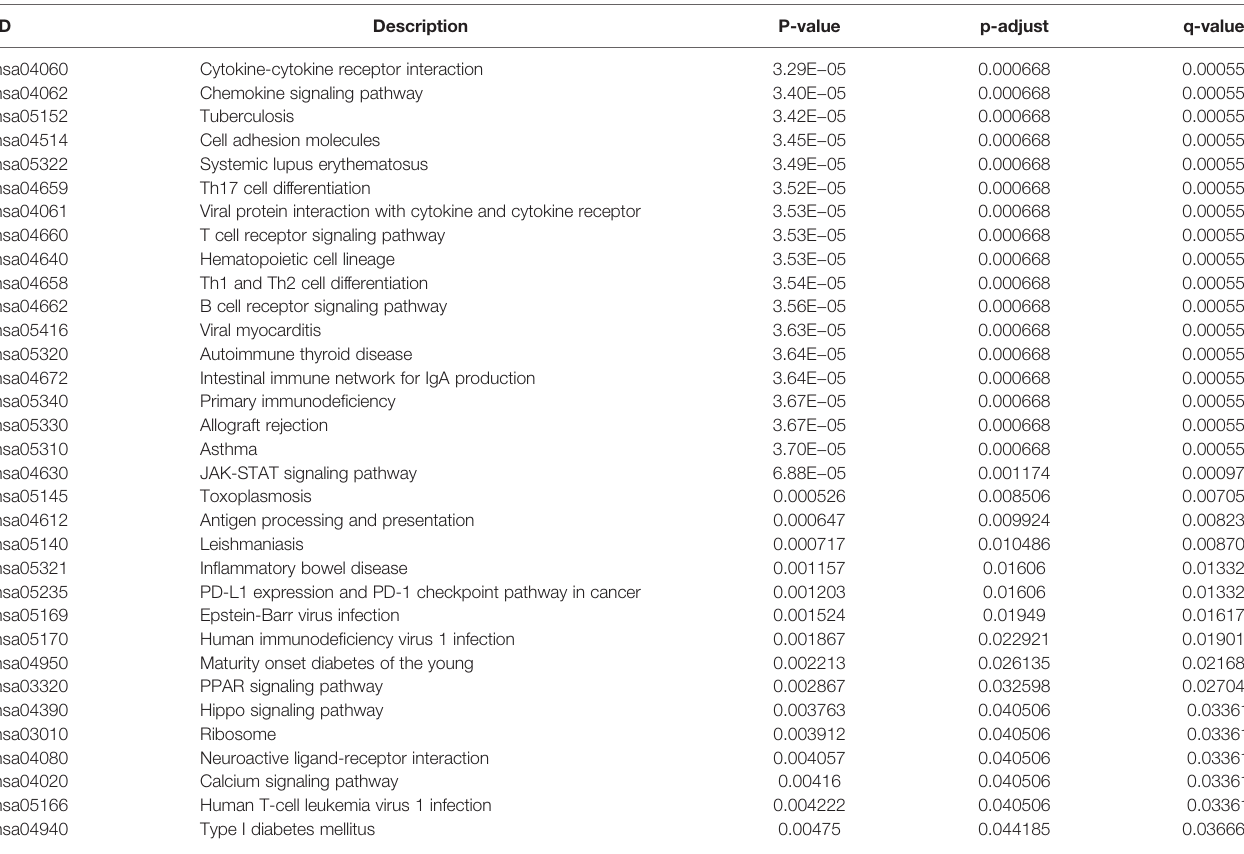
TABLE 3 | Signi fi cant KEGG pathways from GSEA